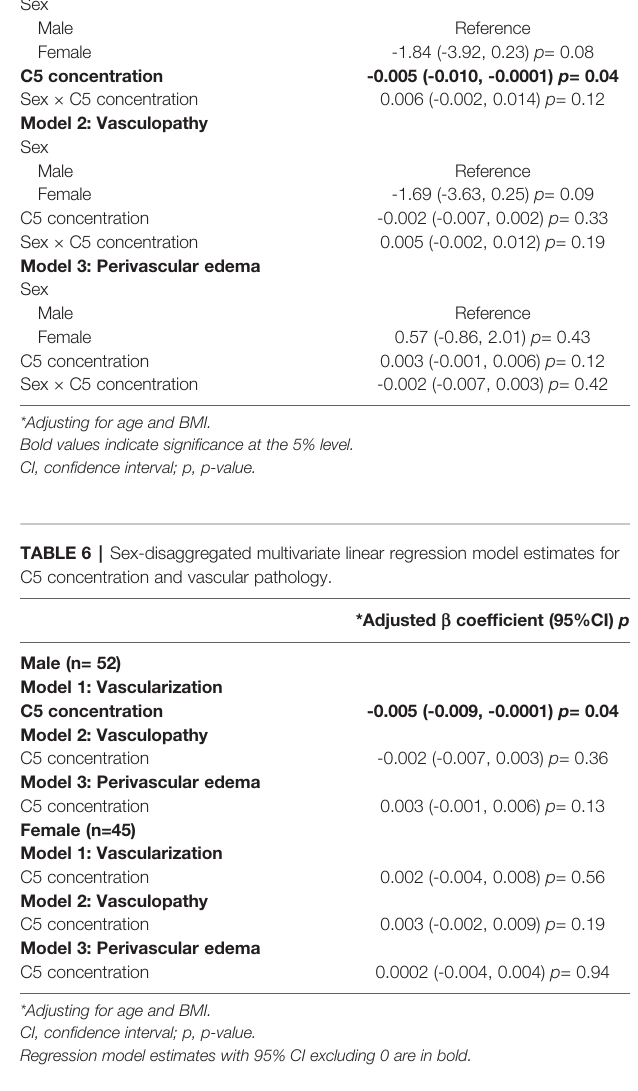
TABLE 4 | Median synovial vascularization: total cohort and disaggregated by sex. Total Cohort (n= 97) mean ± SD (range)